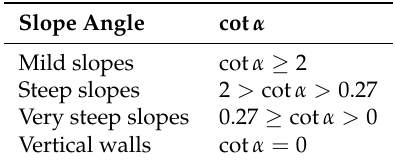
Table 1. Range definition of slope angle α .